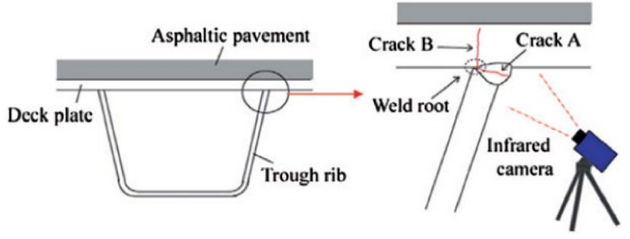
Figure 19. Schematic representation of fatigue cracks and IT inspection at rib-to-deck joint [46].